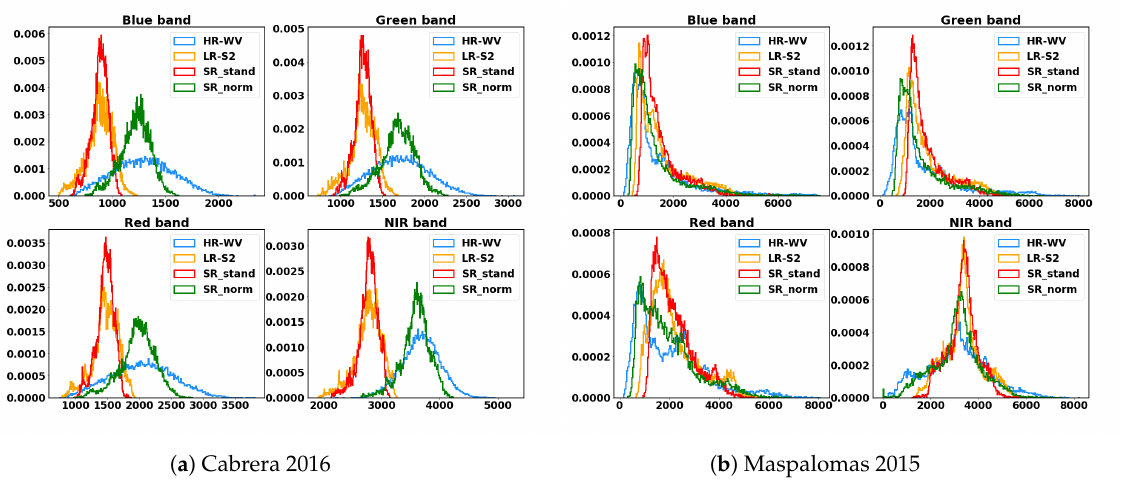
Figure 6. Normalized histograms between the LR, HR and super-resolution (SR) images for each channel: ( a ) Cabrera 2016, ( b ) Maspalomas 2015.